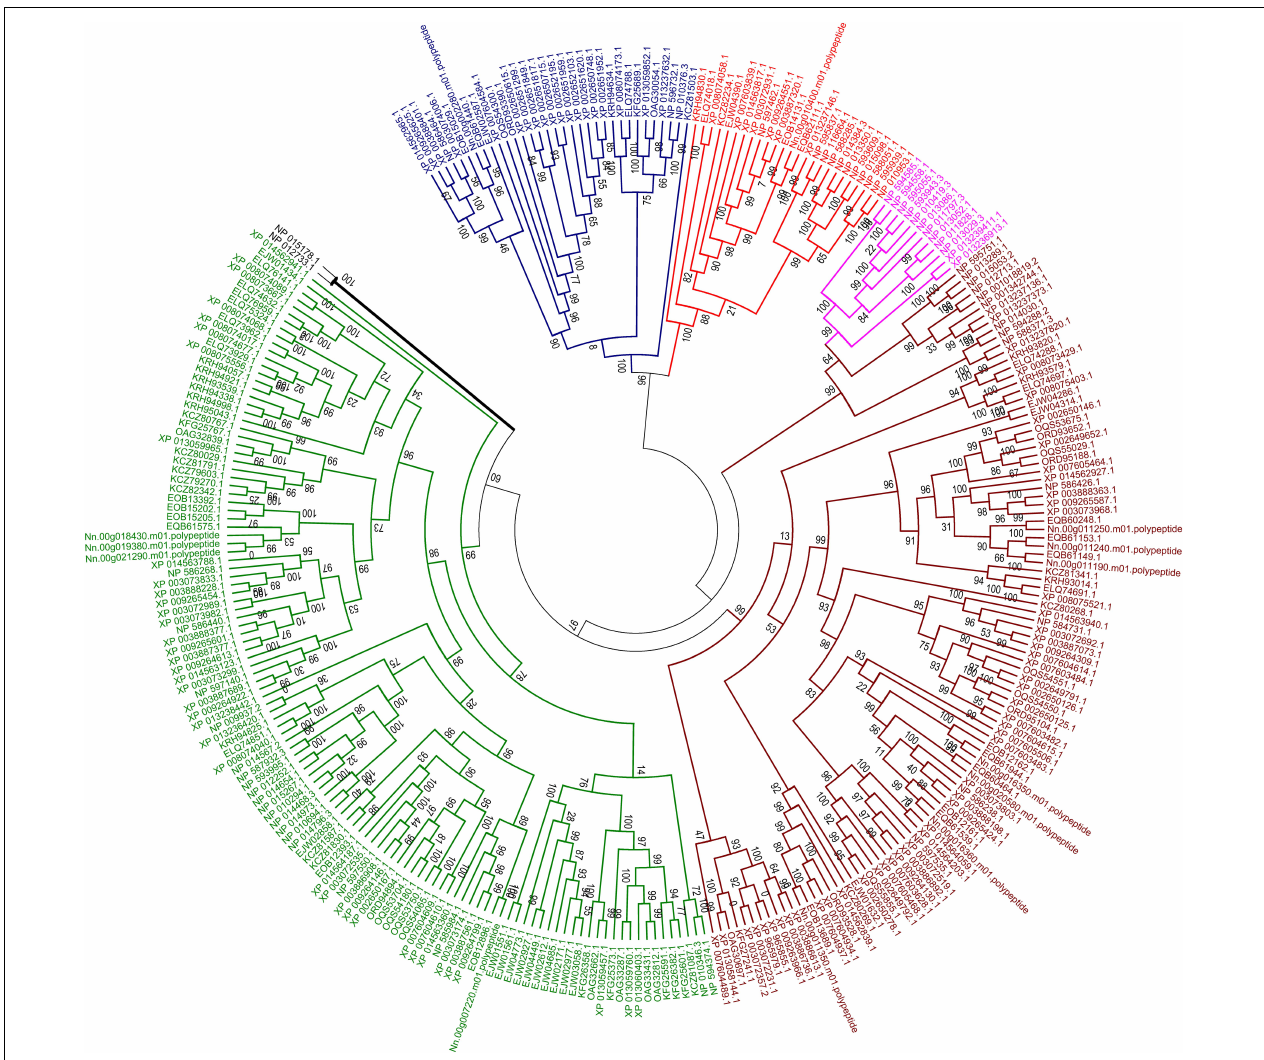
FIGURE 8 | Maximum likelihood phylogenetic tree of ABC transporter proteins of 23 fungal genomes. The tree was based on a total of 293 ABC transporter protein sequences. The unrooted tree was calculated with FASTTREE based on JTT mode with 1,000 replications. The color code associated with each protein indicated the subfamily, with brown for subfamily B, purple for subfamily C, blue for subfamily E, red for subfamily F and green for subfamily G. Two ABC proteins from subfamily D in S. cerevisiae were labeled with black